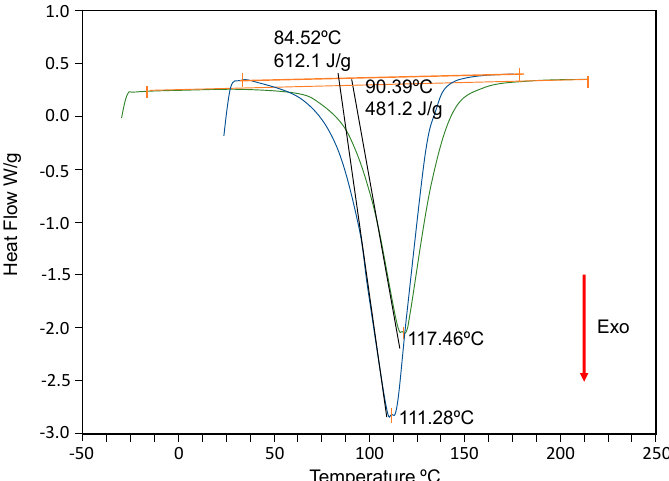
Figure 3. DSC scans of the DGEBA/mXDA (blue line, 111.28 °C [27]) and DGEBA/mXDA/AuNP systems (117,46 °C. black line).